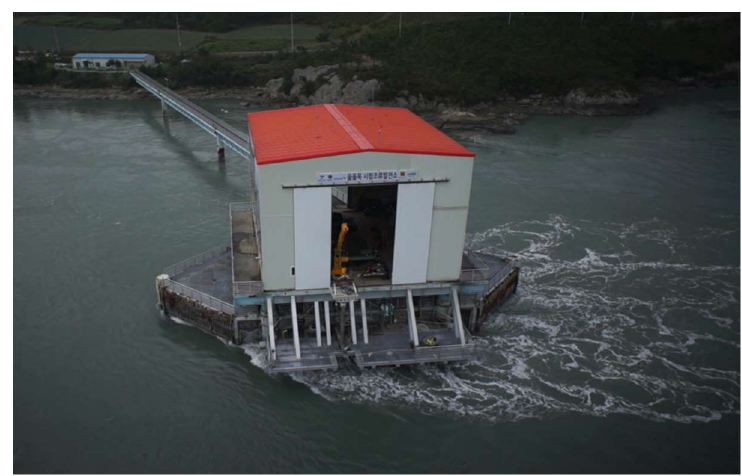
Figure 7. A photo of the Uldolmok Tidal Current Power Pilot Plant.